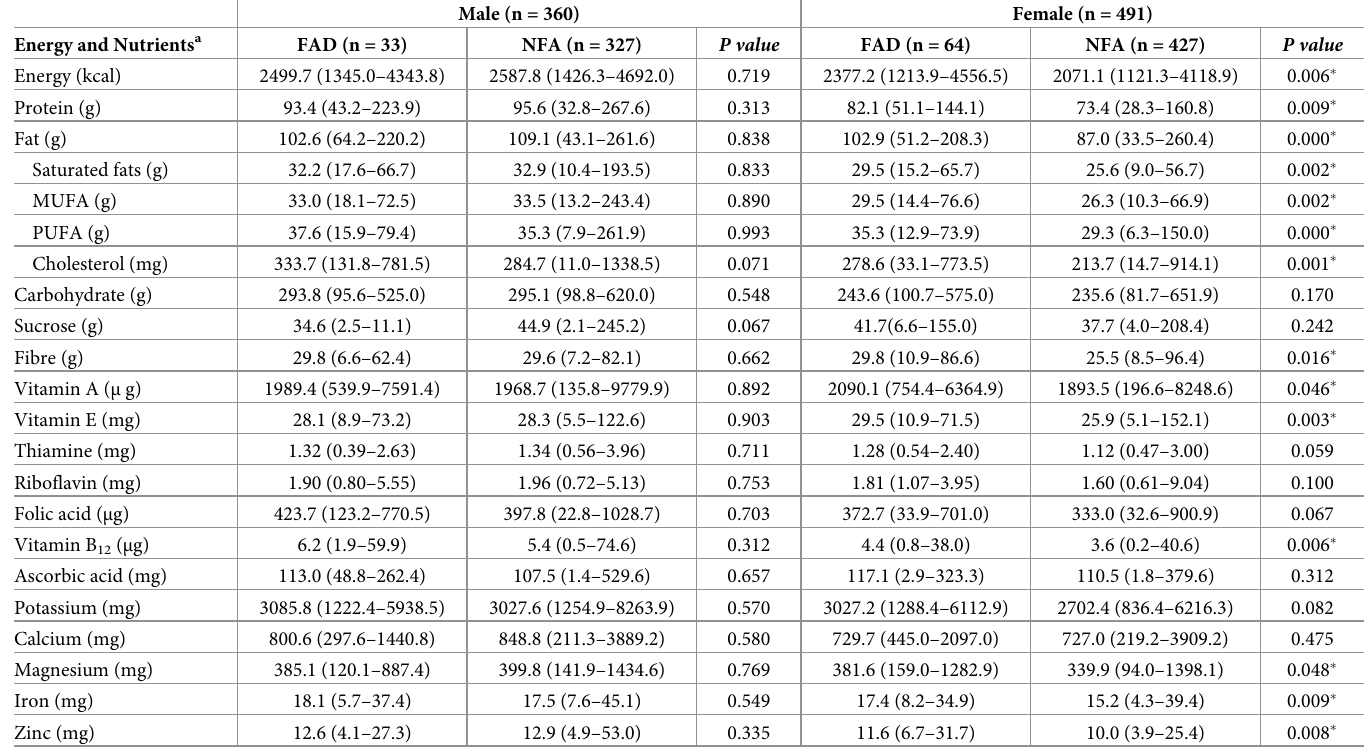
Table 3. Daily dietary energy and nutrient intakes of participants categorized by presence of food